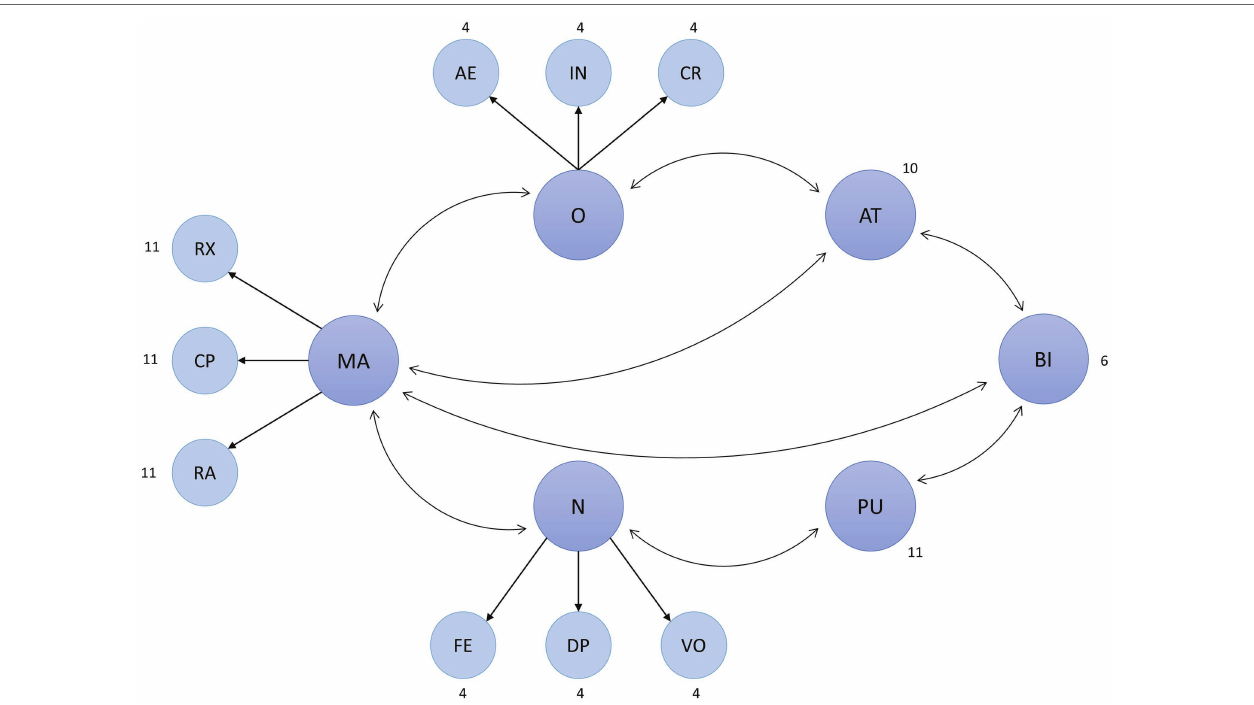
FIGURE 4 | Theory-based CFA model. Resulted in a negative factor variance for the “neuroticism” facet “anxiety.” The numbers next to the latent variables indicate the number of manifest indicator variables for the respective variable. AE, aesthetic interest; AT, attitude toward using MSS; BI, intention to use MSS; CP, cognitive problem solving; CR, creative imagination; DP, depression; FE, fear; IN, intellectual curiosity; MA, modulation of negative affect through music; N, neuroticism; O, openness; PU, perceived usefulness of MSS; RA, reduction of negative activation; RX, relaxation; and VO, emotional volatility.